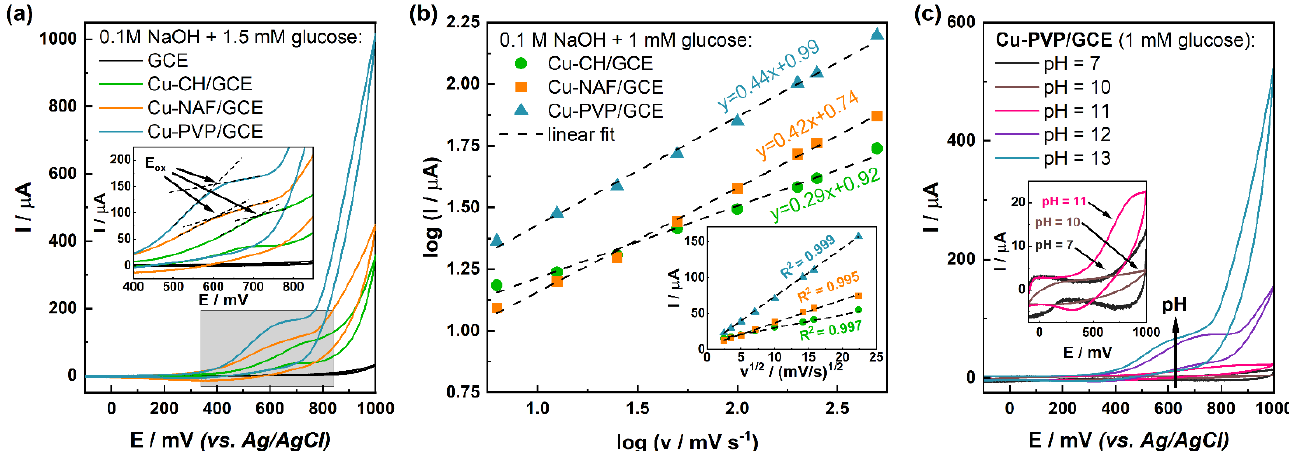
Figure 5. Comparison of: ( a ) cyclic voltammograms for bare and modified GCEs in the presence of 1.5 mM glucose at a scan rate of 100 mV/s (inset shows the magnified potential range of glucose oxidation peak formation), ( b ) logarithmic dependency of scan rate on generated peak current (inset shows dependency of peak current on the scan rate) and ( c ) cyclic voltammograms for Cu-PVP/GCE in the presence of 1 mM glucose in electrolytes with different pH values at a scan rate of 100 mV/s (inset shows magnified region of lower current values).